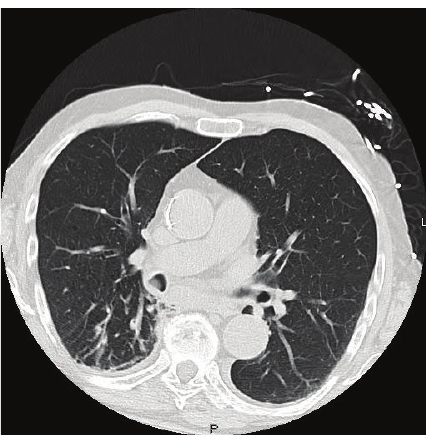
Figure 1: CT scan of chest showing a debris/possible endobronchial lesion in the bronchus intermedius of right lung.